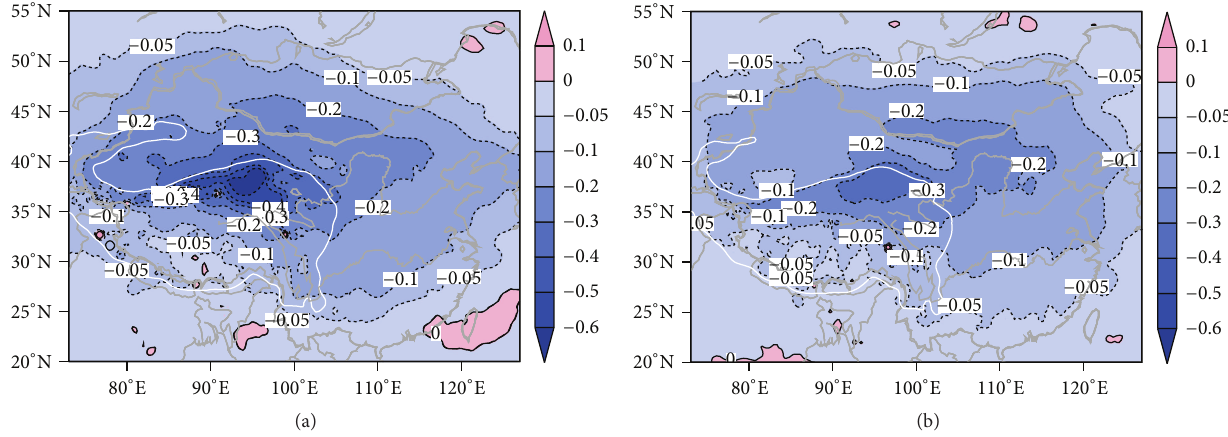
Figure 9: Atmospherictemperaturechanges at 600 hPa over theTPin spring(units: ∘ C)between different numerical experiments: (a)HMD − HM; (b) LMD − LM.